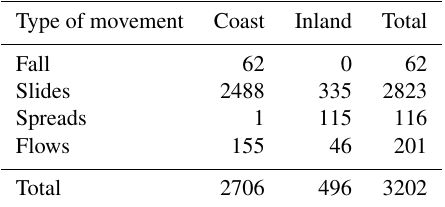
Table 2. Landslide types of movement and